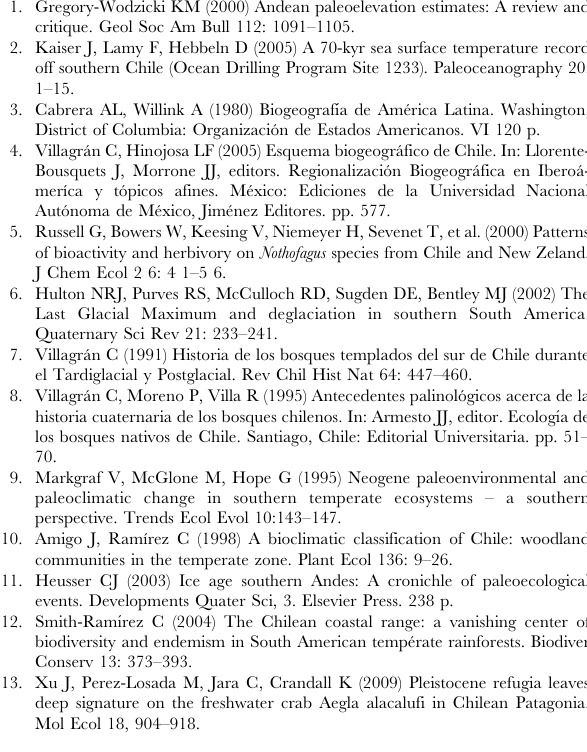
Table S1 Collection localities for Liolaemus pictus, sample sizes (N) and subspecies to which are allocated.